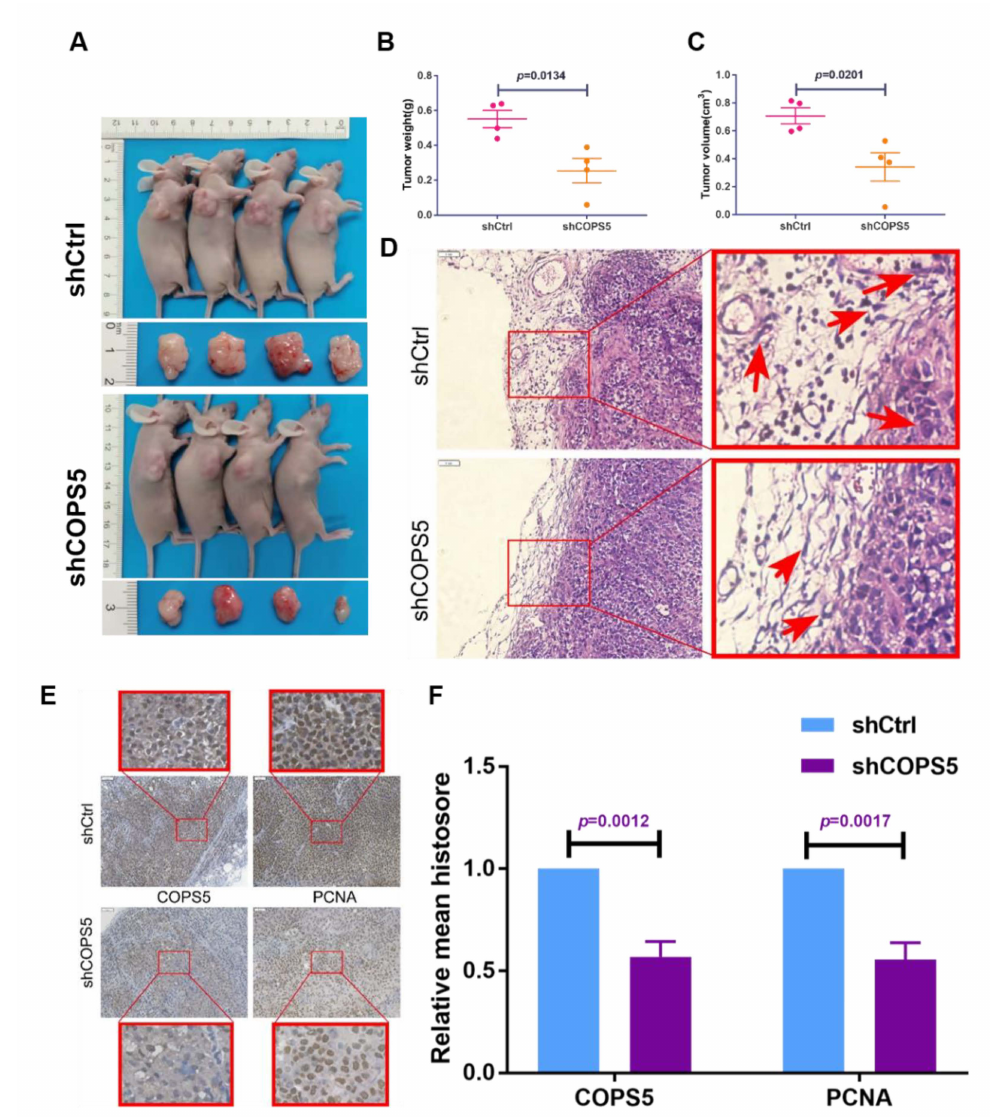
Figure 4. COPS5 silencing sensitized ovarian cancer to platinum in vivo. The tumor growth of mice injected with shCOPS5 ovarian cancer cell line was significantly reduced ( A – C ). HE staining showed that the ability of shCOPS5 tumor cells to invade the surrounding tissue was significantly abrogated, 200 × ( D ). IHC staining showed that the proliferation ability of shCOPS5 tumor cells was inhibited, 200 × ( E , F